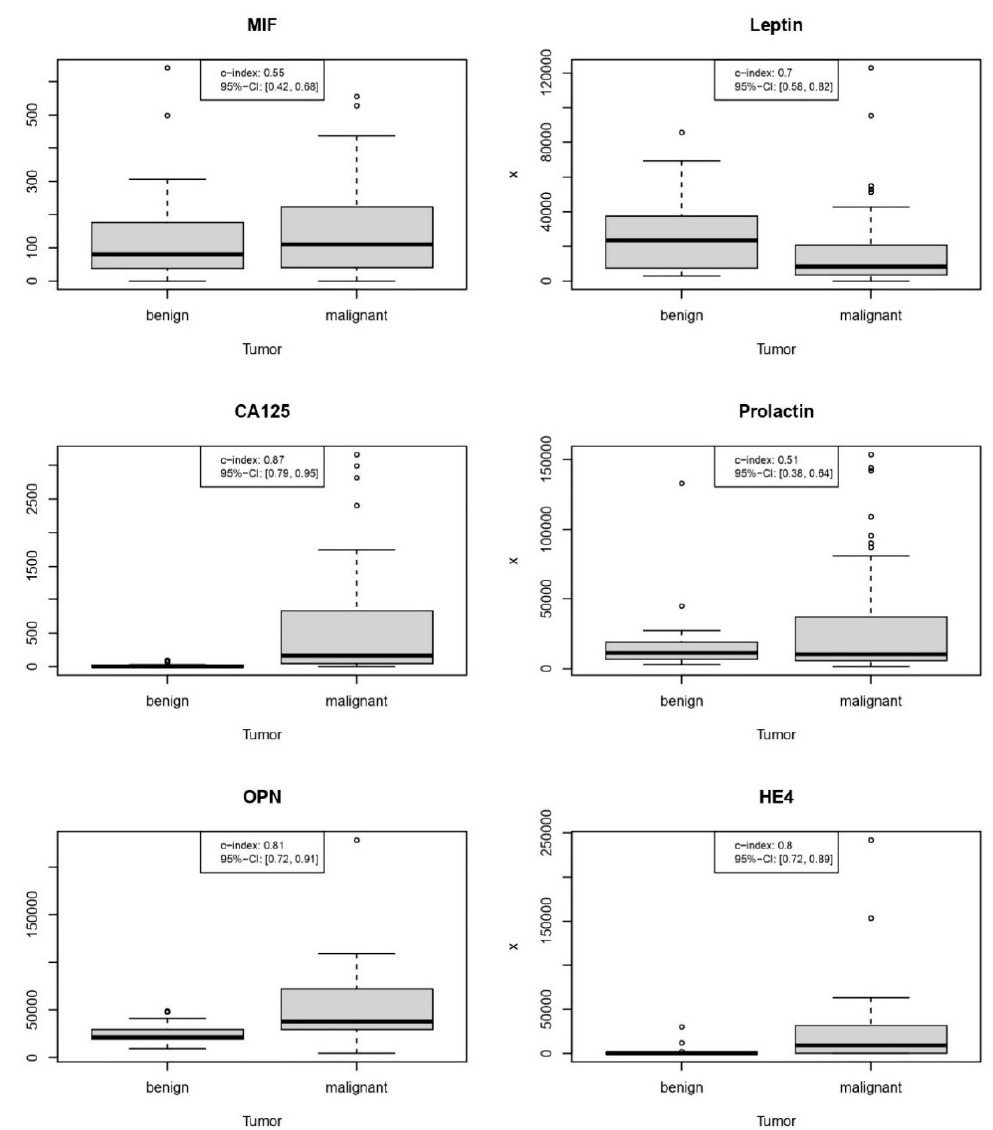
Figure 1. Diagnostic performance of individual protein markers in the validation cohort. Table 2. Discriminative ability of single markers and models.